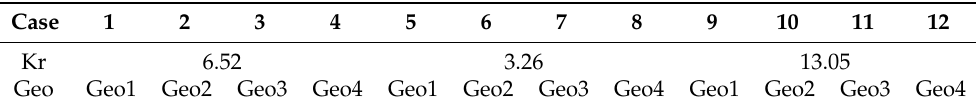
Table 2. The operating conditions of different